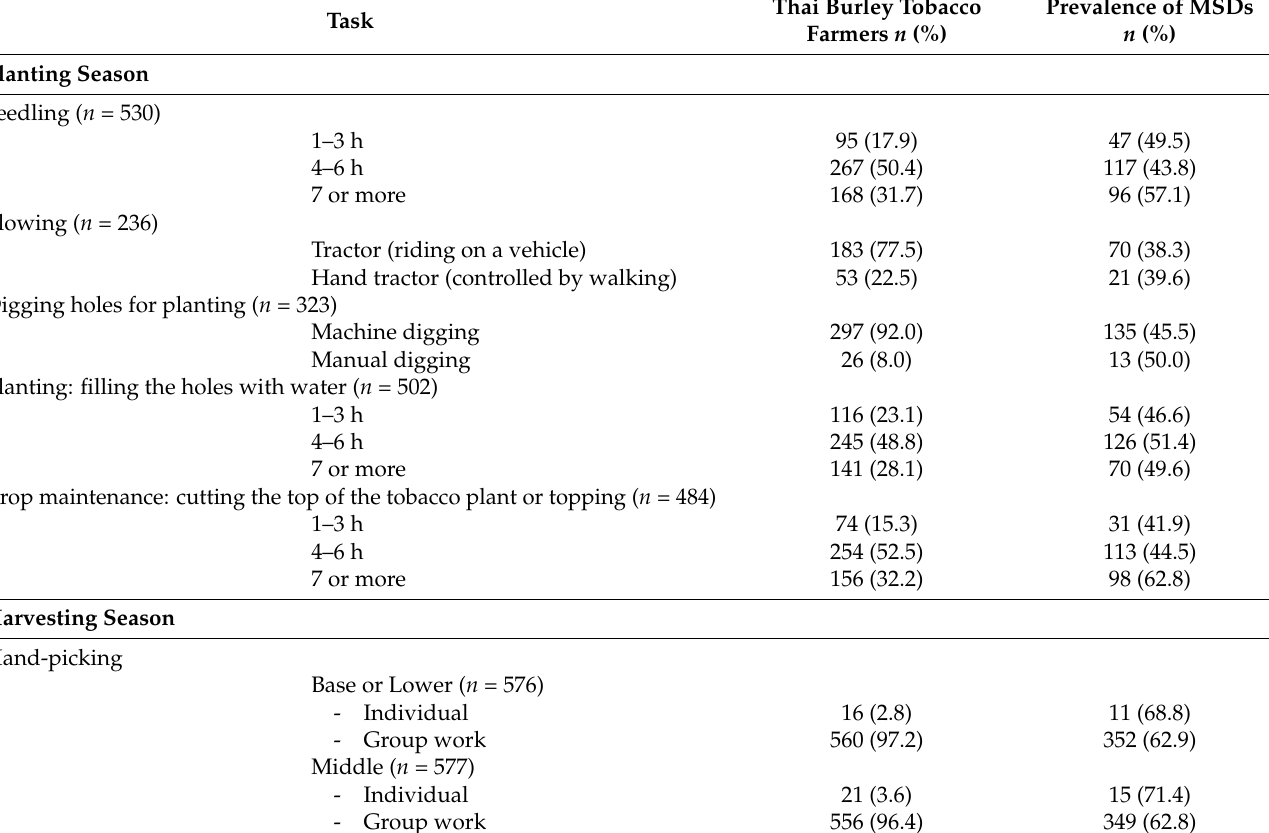
Table 2. Task performed by tobacco farmers during the planting and harvesting season ( n = 603).